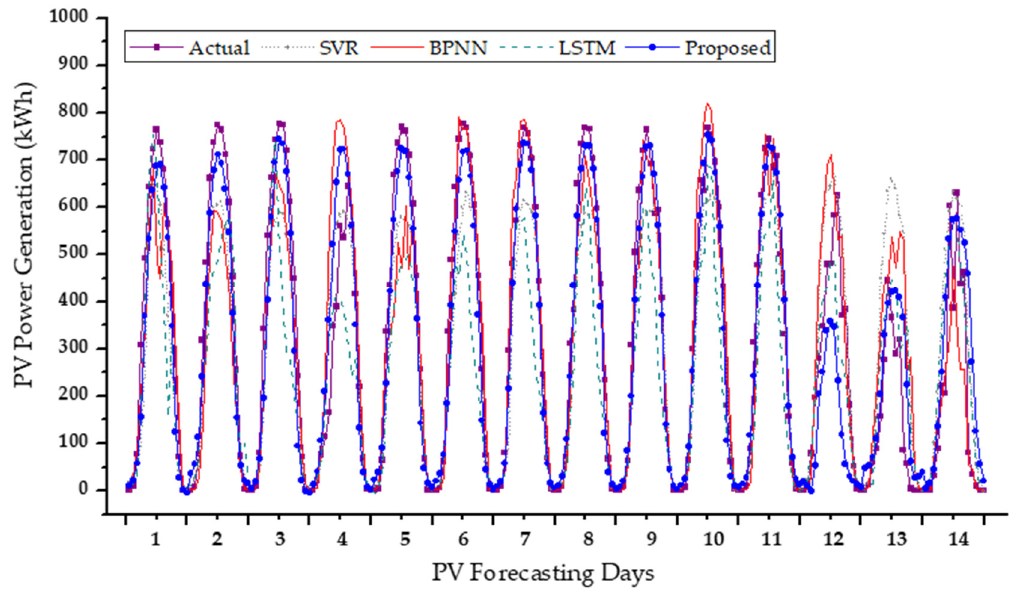
Figure 7. Results of PV power forecasting with and without the proposed similar day detection (SDD).